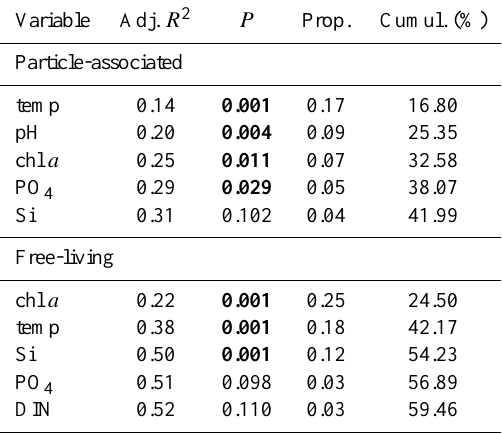
Table 1. Distance-based multivariate multiple regression (DistLM; step wise, adjusted R 2 ) on the relation of environmental variables to the community structure (Bray–Curtis) of particle-attached and free-living bacteria. Significant P -values ( < 0 . 05) are given in bold numbers. Prop. is the proportion of variability explained by the re- spective